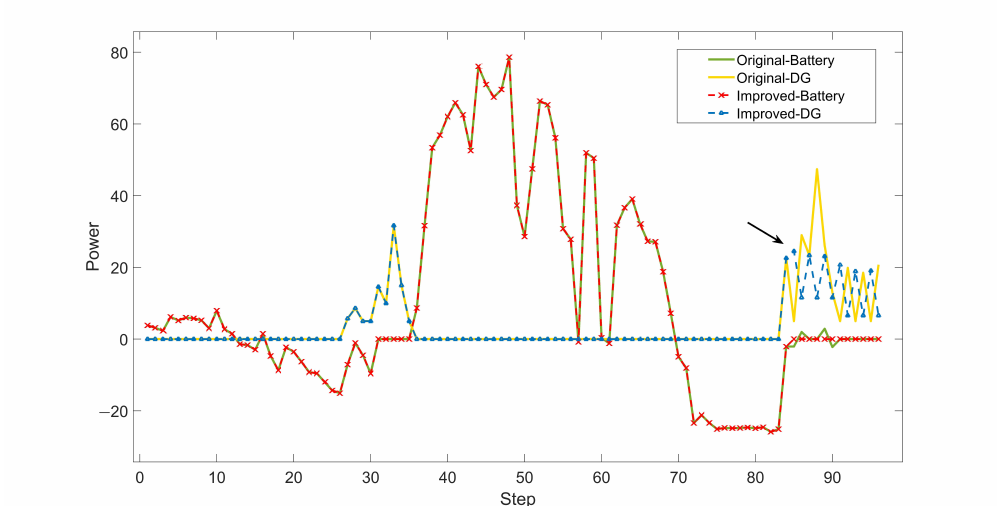
Figure 7. Actual operating power of diesel generators and energy storage units using the improved method and the previous